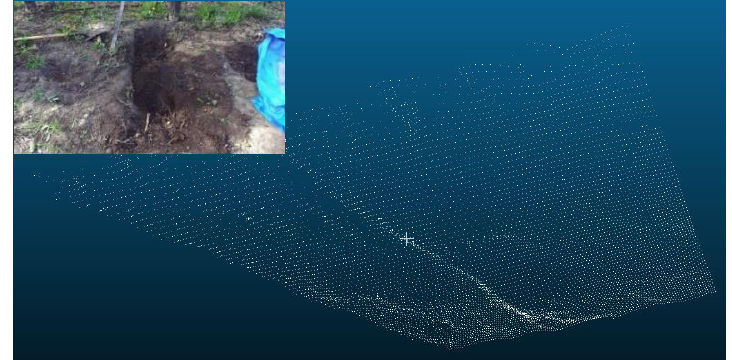
Figure 15. Point cloud of the ground surface before excavation.